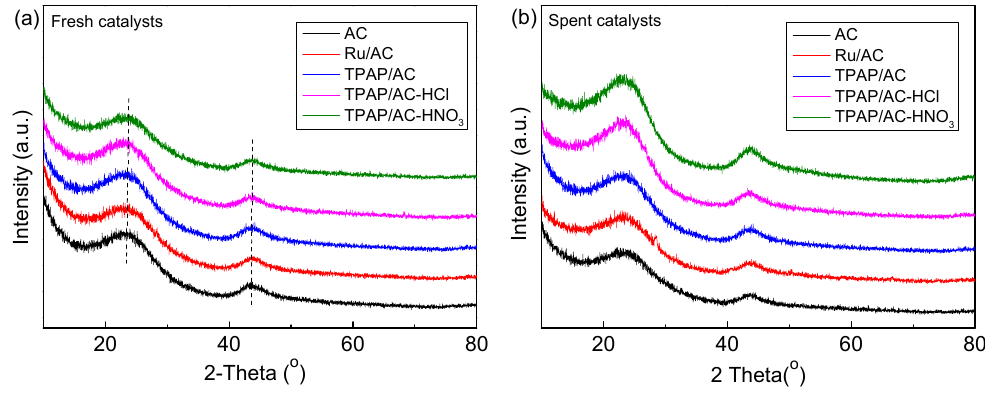
Figure 4. X-ray diffraction (XRD) patterns of the fresh ( a ) and spent ( b ) Ru-based Figure 4. X ‐ ray diffraction (XRD) patterns of the fresh ( a ) and spent ( b ) Ru ‐ based catalysts.